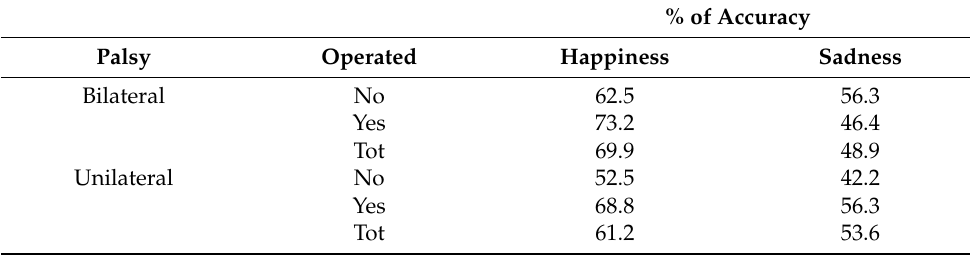
Table 2. The median percentage accuracy scores in both bilateral/unilateral and operated/not operated MBS patients. These subsamples included 8 bilateral patients, of which 7 received the smile surgery procedure and 1 did not, and 7 unilateral patients, of which 3 received the smile surgery procedure and 4 did not.